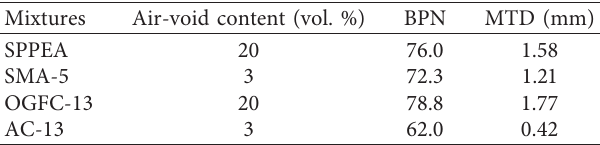
Table 4: BPN from British pendulum tester and MTD from sand patch test